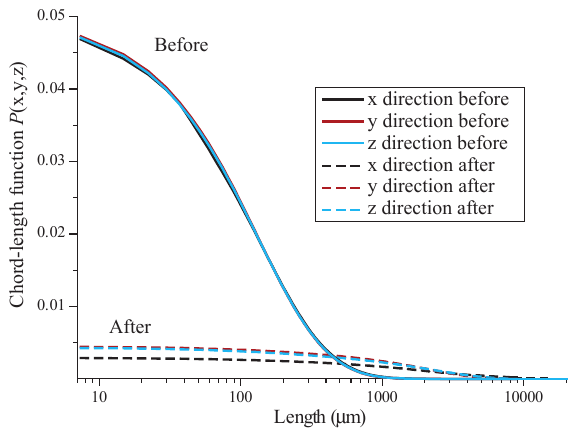
Figure 10. Porosity change along samples Bvl be and Bvl af . Both resolved and sub-resolved porosities are